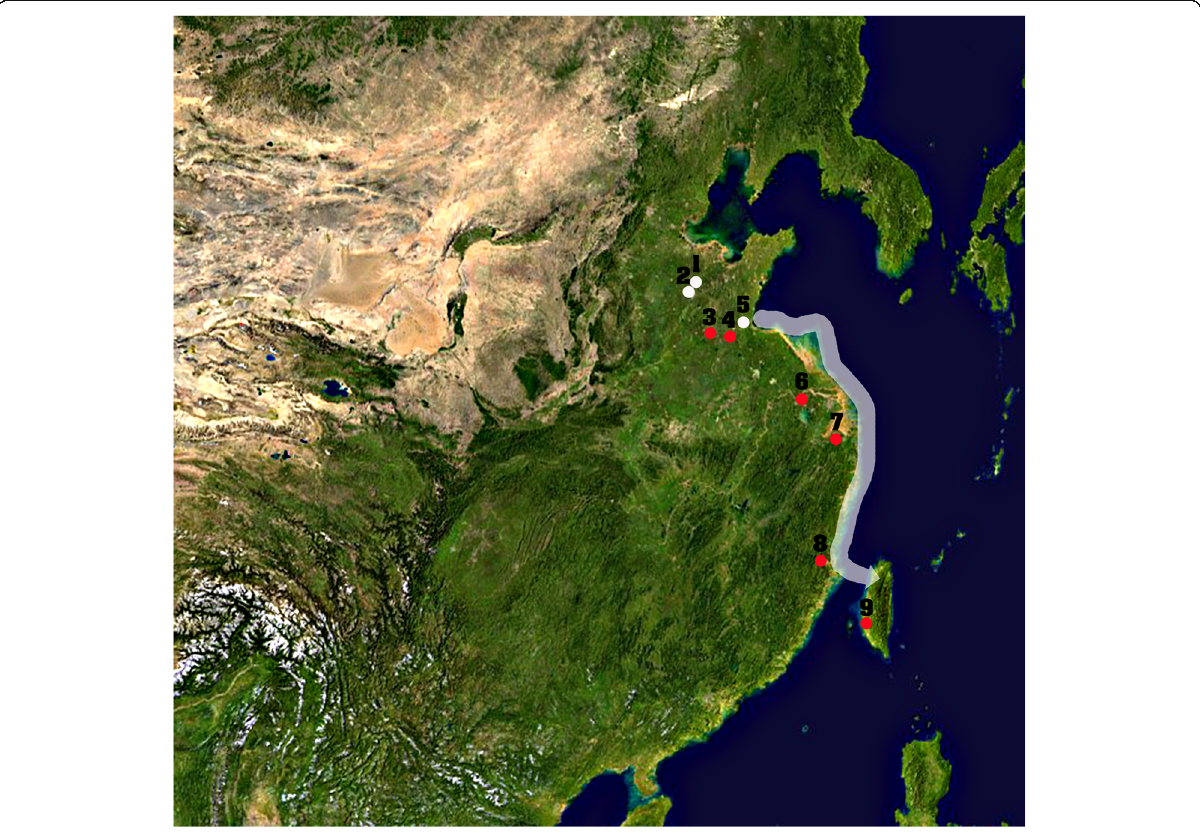
Fig. 4 Archaeological sites in this study and the proposed migration route. 1, Zhangmatun; 2, Yuezhuang; 3, Beixin; 4, Dadunzi; 5, Dongpan; 6, Weidun; 7, Hemudu; 8, Tanshishan; 9, Nankuanli. Sites where tooth ablation is reported are indicated by red dots. The arrow shows the proposed migration route of the pre-Austronesians from Shandong to Taiwan. The northeastern Asia image was downloaded from